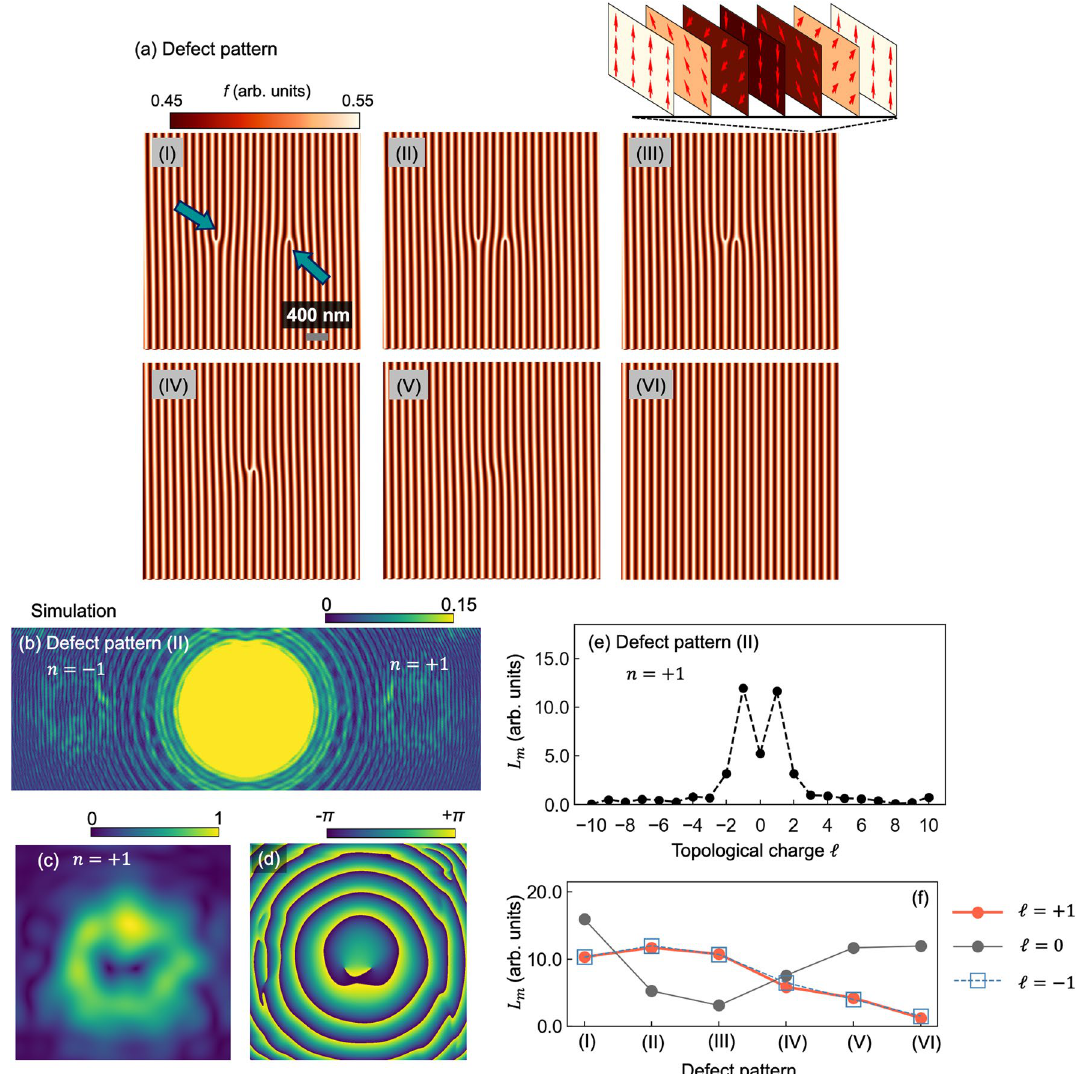
Figure 4. Simulation of inline holography for pair annihilation of edge dislocations in a helical magnetic texture. ( a ) (I)–(VI) Schematic of pair annihilation of the defects. Positive and negative edge dislocations (indicated by arrows in figure (I)) annihilate when they meet. ( b ) Holographic pattern calculated for n = ± 1 diffraction from defect pattern II. ( c ) A (ρ fn , φ fn ) , ( d ) phase distribution, and ( e ) TC spectrum for the n = + 1 diffraction wave. ( f ) L m of ℓ = ± 1, 0 for the n = + 1 diffraction wave generated from each defect